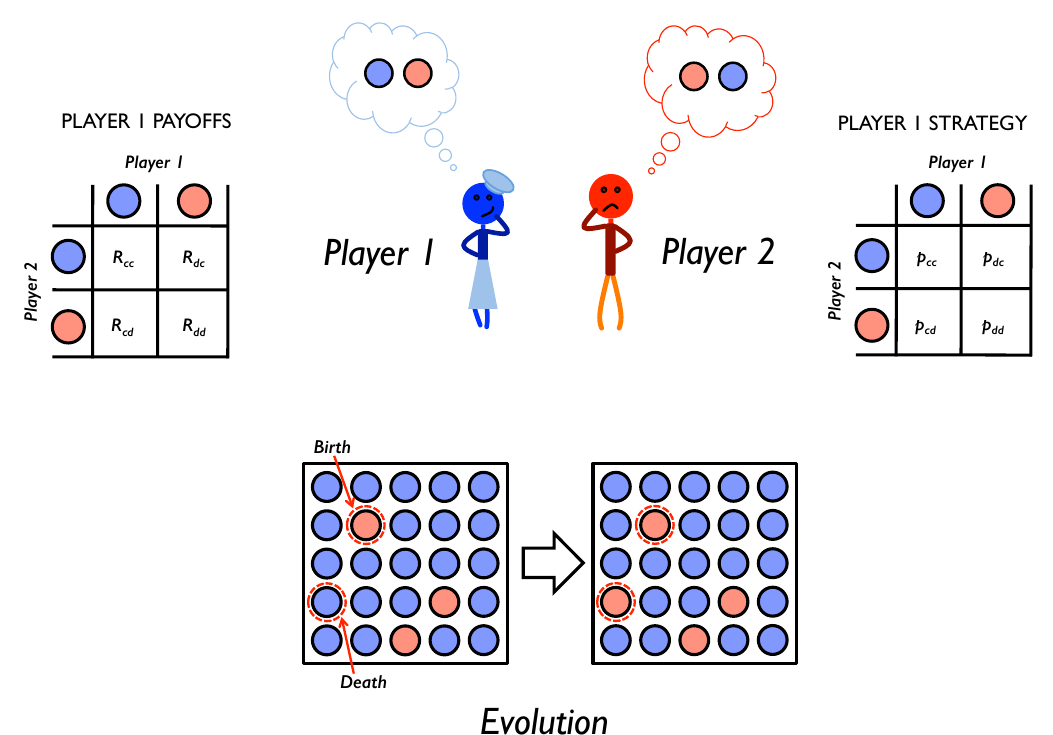
Figure 1. Evolving social interactions. We study repeated pairwise social interactions using 2 × 2 iterated games. Over the course of multiple interactions, players choose whether to cooperate (blue circle) or defect (red circle), depending on the outcome of their previous interaction. A player’s probability of cooperation given her previous interaction is encoded as a memory-1 strategy (right). Depending on the outcome of each interaction, she receives a payoff (left). To study the evolution of social interactions, we assume that each player’s reproductive success is proportional to the payoff she receives from all social interactions with all other members of the population. This leads to an evolution in the strategies used in the population (bottom) and allows us to explore the conditions under which cooperation will